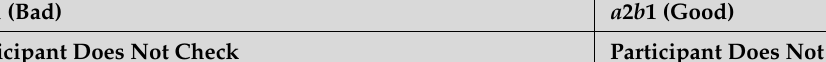
Table 2. The good and bad matrices for a2b1 and a2b2 trials in Experiment 1. The payoff matrices for a 1 b 1 and a 1 b 2 trials had a format closely analogous to that for a 2 b 1, and variations were employed to create the requisite number of trials. a 2 b 1